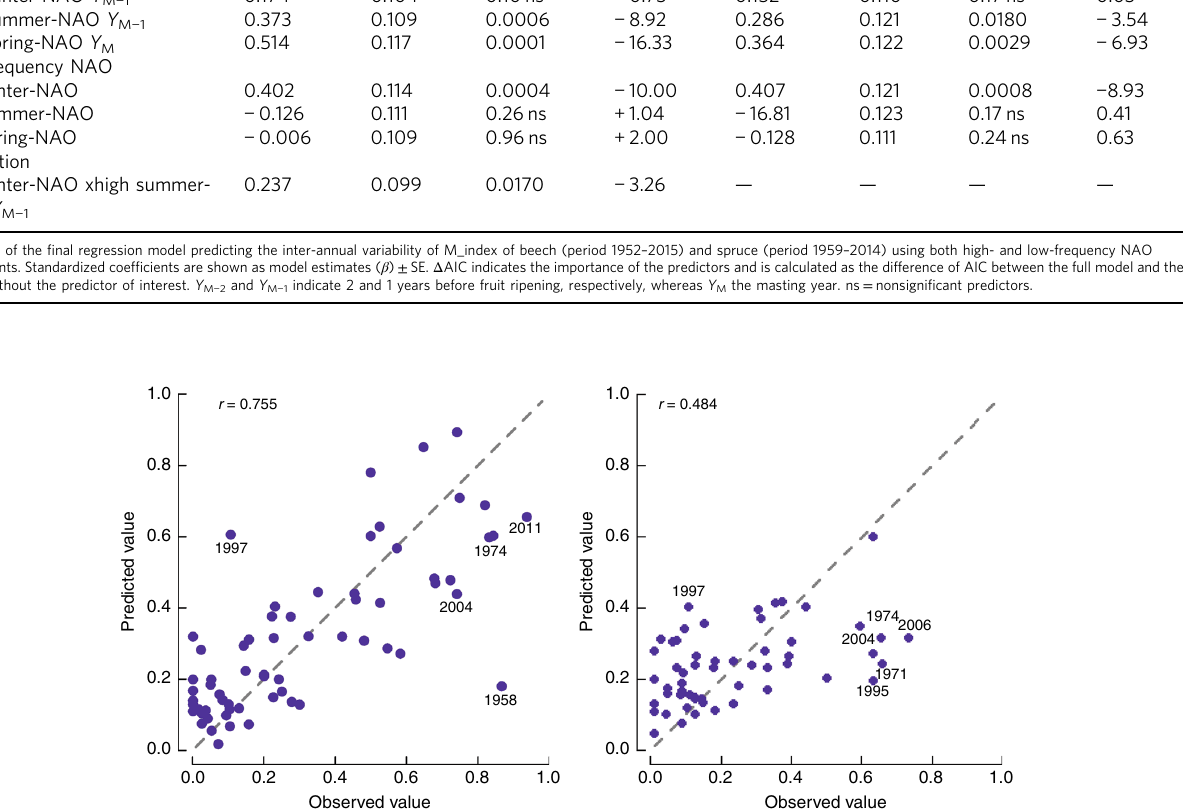
Fig. 3 Leave one out cross-validation. Observed and predicted values of beech (left) and spruce (right) M_index from the LOOCV of the fi nal model. The dashed line represents the perfect match between observed and predicted values. Years with the largest disparity are labeled